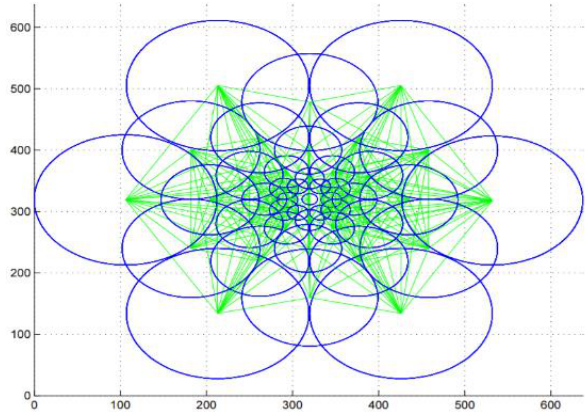
Figure 8. Fast retina keypoint (FREAK) descriptor used 43 sampling patterns [19].